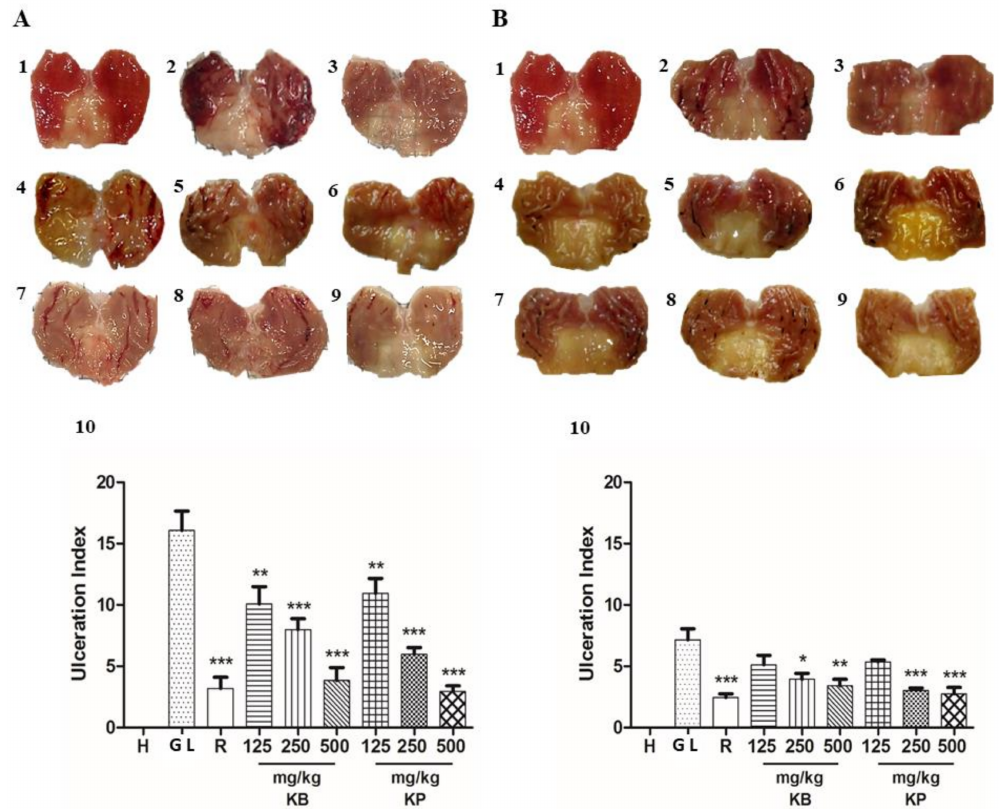
Figure 3. Effect of pre-treatment with K. brasiliensis and K. pinnata leaf juice (125, 250 and 500 mg/kg) on the macroscopic appearance of the gastric mucosa in ethanol-induced and indomethacin-induced gastric mucosal lesions in rat ( A ) Ethanol-induced: (1) Healthy; (2) Gastric lesion control; (3) Ranitidine 50 mg/kg; (4) K. brasiliensis 125 mg/kg; (5) K. brasiliensis 250 mg/kg; (6) K. brasiliensis 500 mg/kg; (7) K. pinnata 125 mg/kg; (8) K. pinnata 250 mg/kg; (9) K. pinnata 500 mg/kg; (10) Results expressed as mean ± standard mean error, ( n = 7). ANOVA and Dunnett’s post-test were used to calculate the statistical significance, ** p < 0.01 and *** p < 0.001 vs. gastric lesion control. Healthy, H; Gastric lesion control, GL; Ranitidine (50 mg/kg), R. ( B ) Indomethacin-induced: (1) Healthy; (2) Gastric lesion control; (3) Ranitidine 50 mg/kg; (4) K. brasiliensis 125 mg/kg; (5) K. brasiliensis 250 mg/kg; (6) K. brasiliensis 500 mg/kg; (7) K. pinnata 125 mg/kg; (8) K. pinnata 250 mg/kg; (9) K. pinnata 500 mg/kg; (10) Results expressed as mean ± standard mean error, ( n = 7). ANOVA and Dunnett’s post-test were used to calculate the statistical significance, * p < 0.05, ** p < 0.01 and *** p < 0.001 vs. gastric lesion control. Healthy, H; Gastric lesion control, GL; Ranitidine (50 mg/kg),